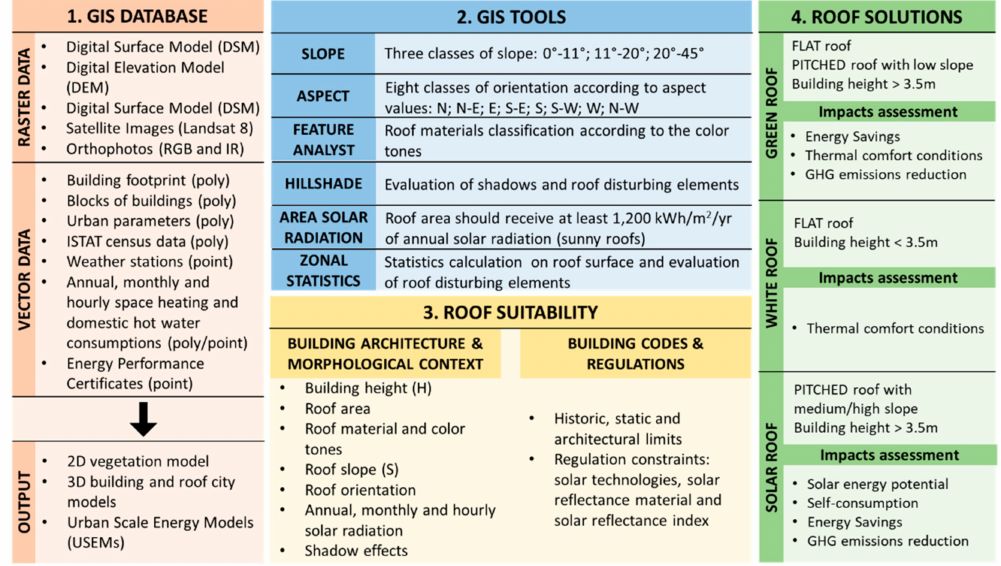
Figure 1. Flowchart of materials, methods, and